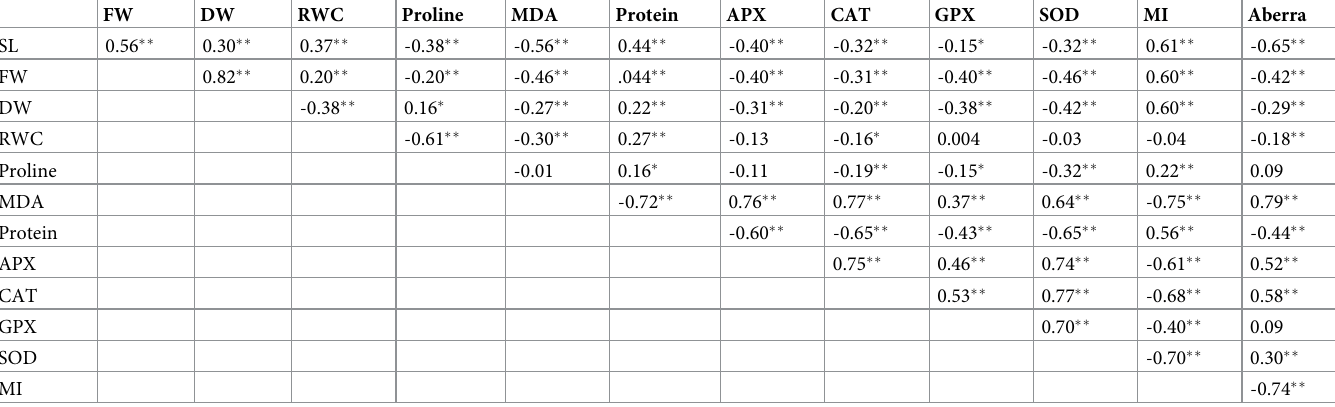
Table 4. Pearson correlation coefficient among all tested parameters in mung bean seedlings grown under Cd stress with prior application of phytohormones and proline.